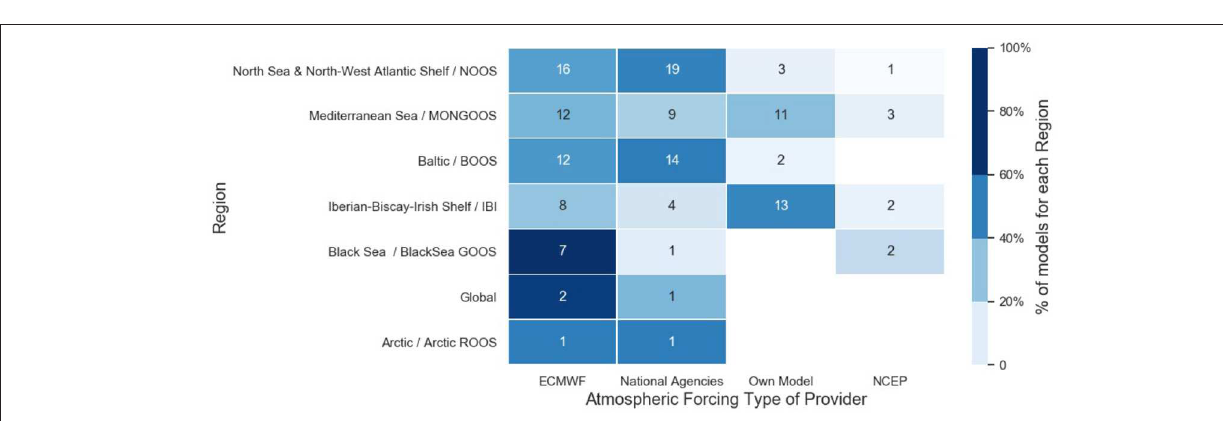
FIGURE 9 | Type of atmospheric forcing sources considered per region. Numbers inside each box represent the total number of models.